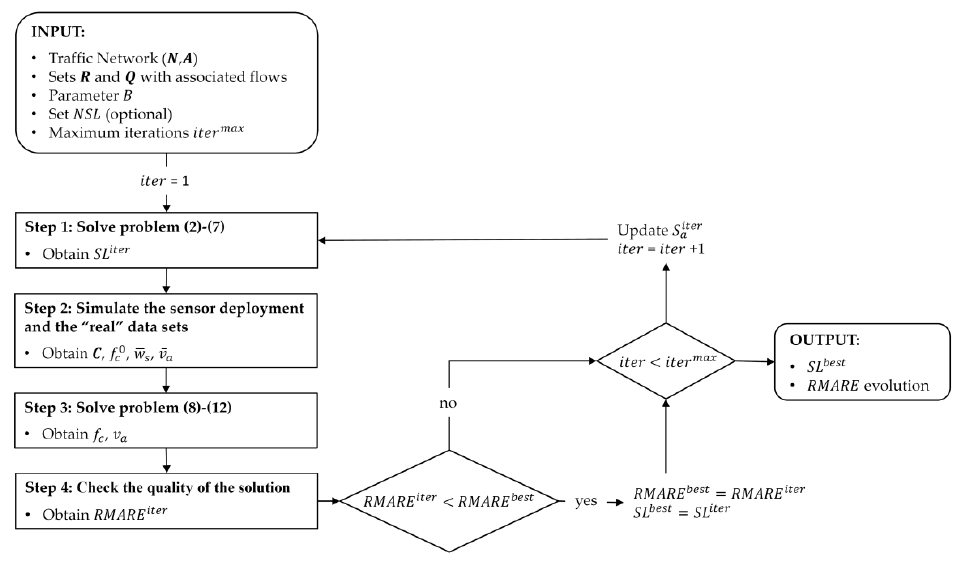
Figure 9. Flowchart of the algorithm defined for the ANPR sensor location model.